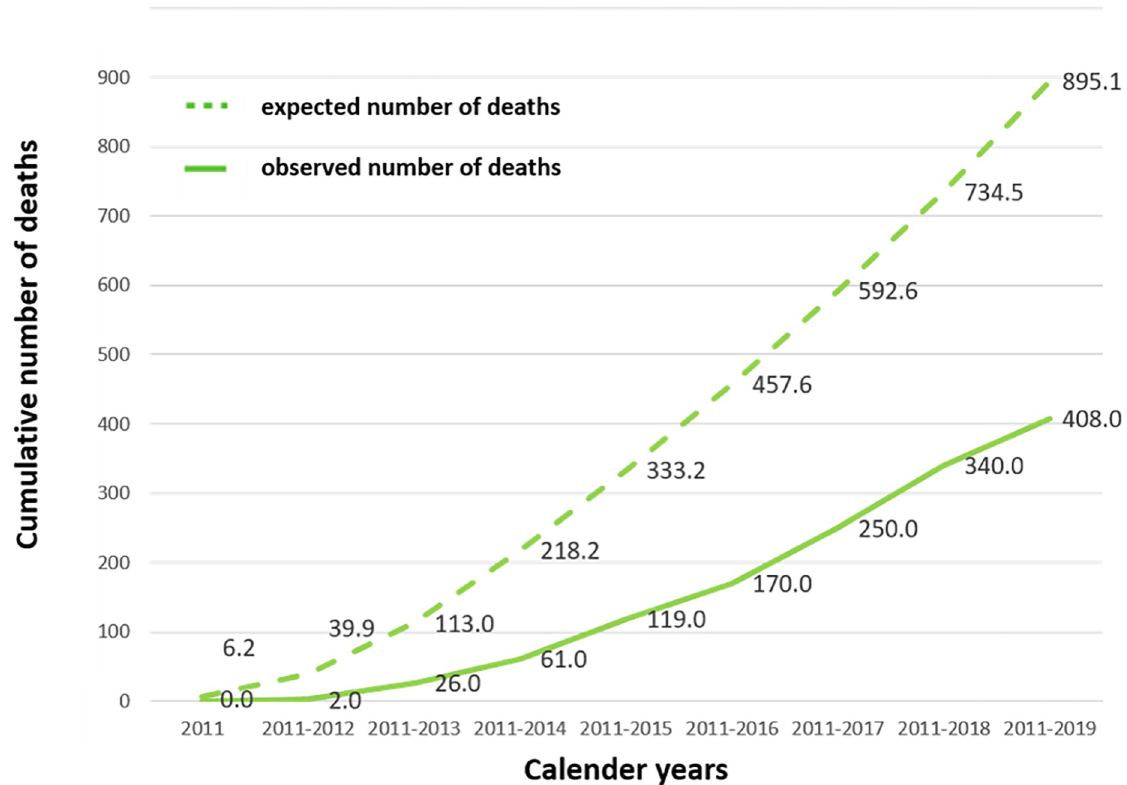
Fig 1. Cumulative numbers of death. Shown are the cumulative numbers of deaths. The solid line shows the observed numbers of deaths within the population investigated in the LIFE-ADULT-Study and the broken line the expected number of deaths for the LIFE-ADULT-Study. The expected number of deaths is calculated based on the life table